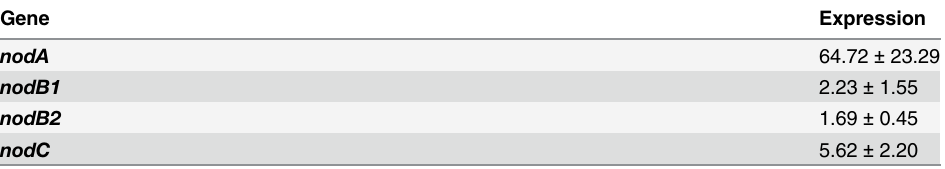
Table 2. Expression of the Dg1 genes nodA , nodB1 , nodB2 , and nodC in D . glomerata nodules given in relative units.